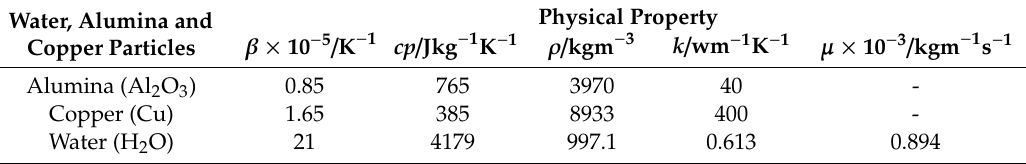
Table 3. Physical properties of water H 2 O, alumina (Al 2 O 3 ), and Copper (Cu). Water, Alumina and Copper